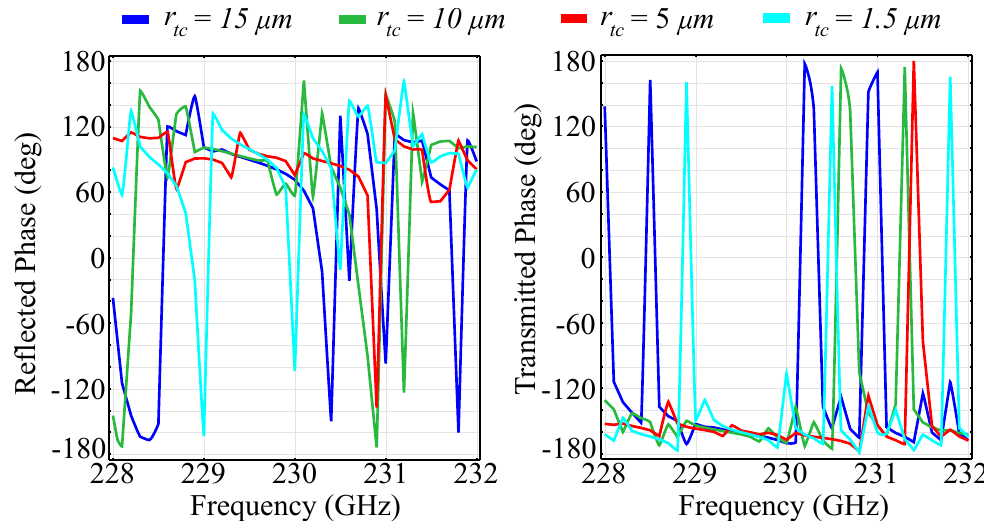
Figure 5. Simulated phase of the reflected and transmitted waves in the silicon substrate configuration, in which the top radius of the inner-ring cylinder r tc is varied between fixed values, in a transition from a cylinder to a cone